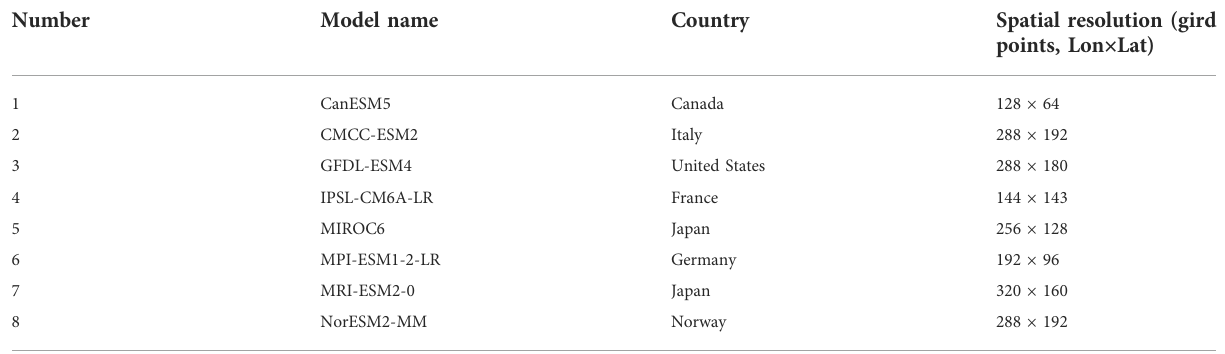
TABLE 1 Basic information of 8 models in CMIP6 chosen for future runoff